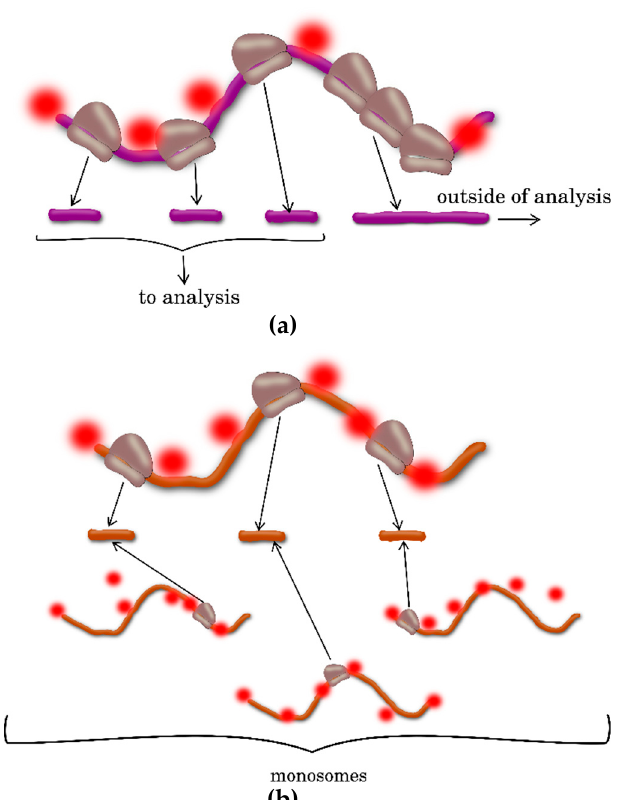
Figure 5. Limitations in the use of ribosome profiling: ( a ) overestimation of translation efficiency because of the footprints of monosomes, where mRNA is also protected by ribosome and ( b ) underrepresentation of the transcript region with stacked ribosomes; carefully stacked polysomes are inaccessible to RNases, thus cannot be digested into ribosome footprints of the tested size (28–30 nucleotides). Red spots denote the region attacked by RNase.